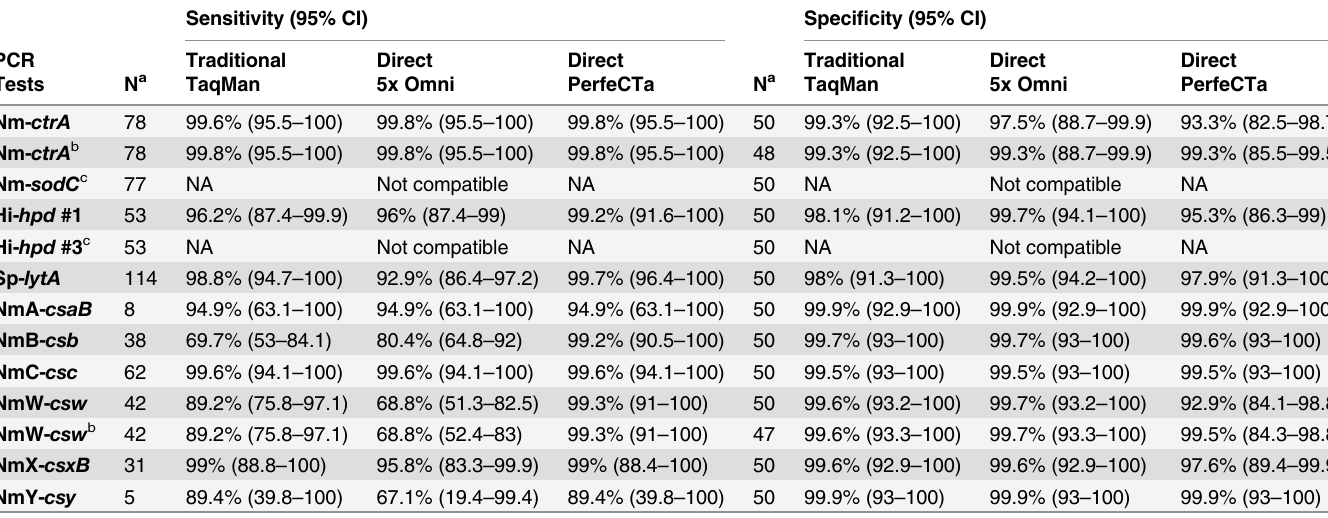
Table 3. Diagnostic sensitivity and specificity for the real-time PCR tests by latent class